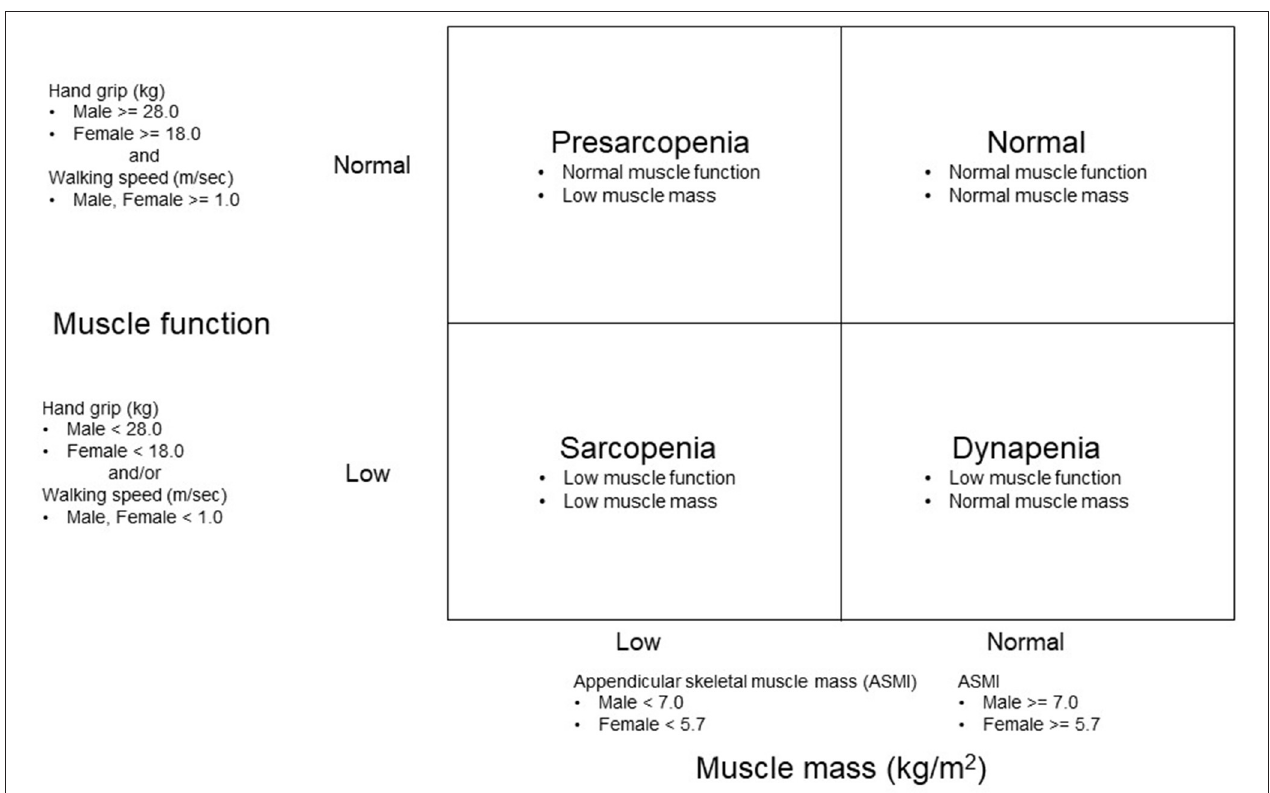
FIGURE 1 | Methods of grouping based on an appendicular skeletal mass index (ASMI) and muscle